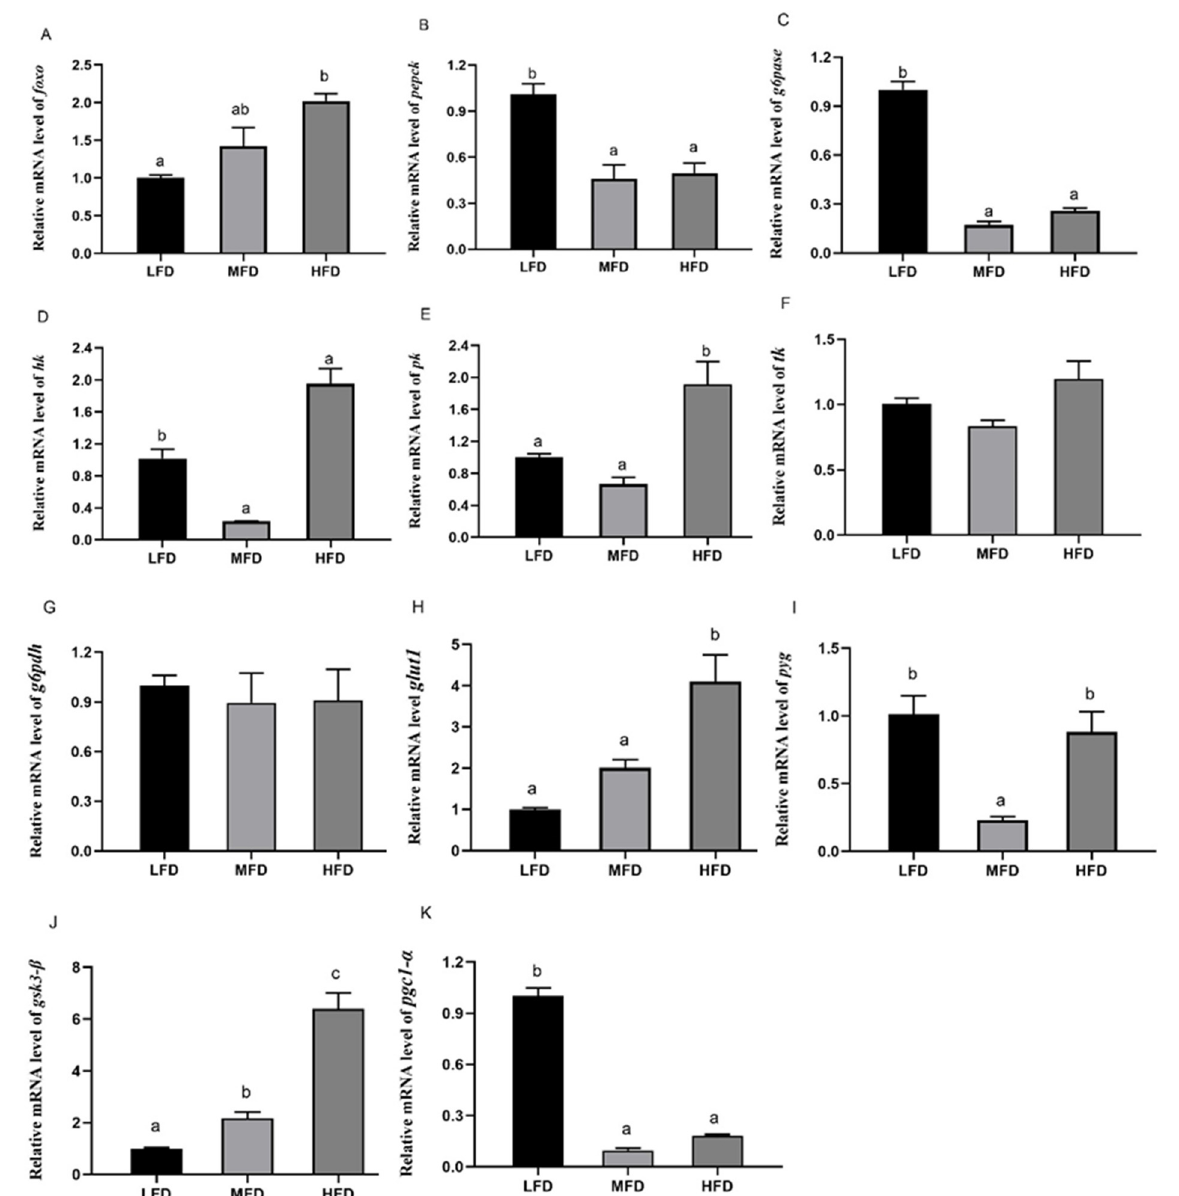
Figure 7. Relative mRNA levels in the hepatopancreas of abalone after feeding trial. The mRNA levels of foxo ( A ), phosphoenolpyruvate carboxykinase ( pepck ) ( B ), glucose-6-phosphatase ( g6pase ) ( C ), hexokinase ( hk ) ( D ), pyruvate kinase ( pk ) ( E ), transketolase ( tk ) ( F ), glucose-6-phosphate dehydrogenase ( g6pdh ) ( G ), glucose transporter 1 ( glut1 ) ( H ), glycogen phosphorylase ( pyg ) ( I ), glycogen synthase kinase-3 β ( gsk3- β ) ( J ), and peroxisomal promoter receptor co-activator 1 α ( pgc1- α ) ( K ) were evaluated using qPCR. Values are represented as mean ± S.E., n = 3. Values with different letters are significantly different ( p < 0.05).